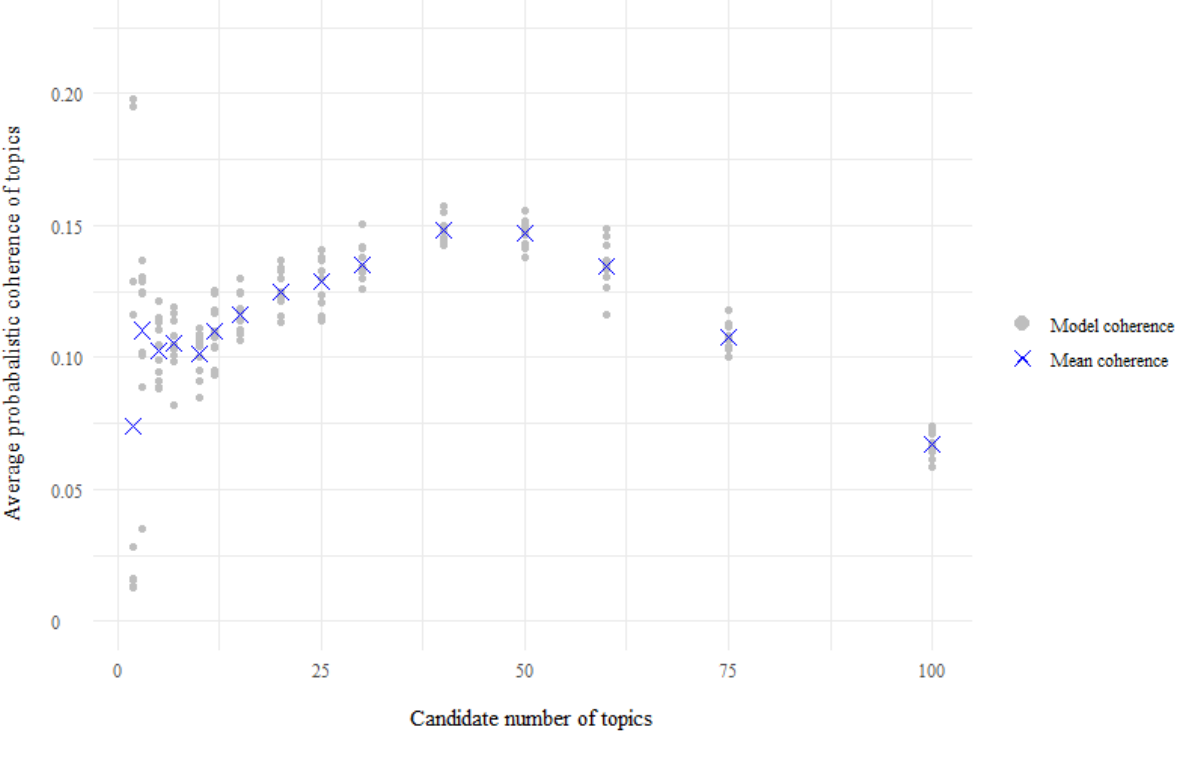
Figure 4. Average probabilistic coherence scores for the models—LifeInfo health and fitness app question, 10-fold cross-validation of topic modelling to establish the optimal number of topics for latent Dirichlet